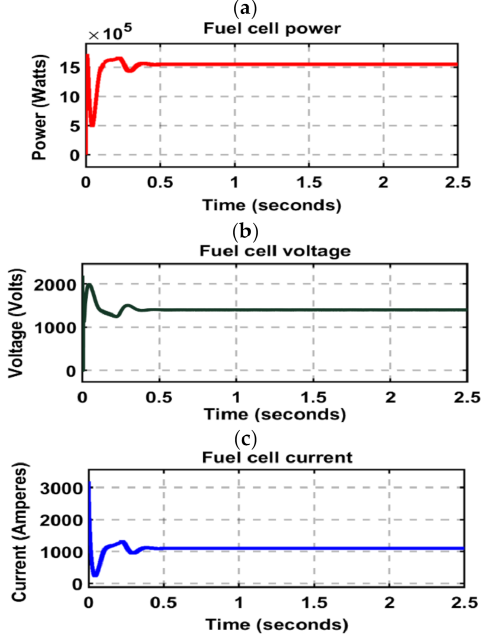
Figure 4. ( a ) Multi-stack fuel cell output power, ( b ) voltage, and ( c ) current.